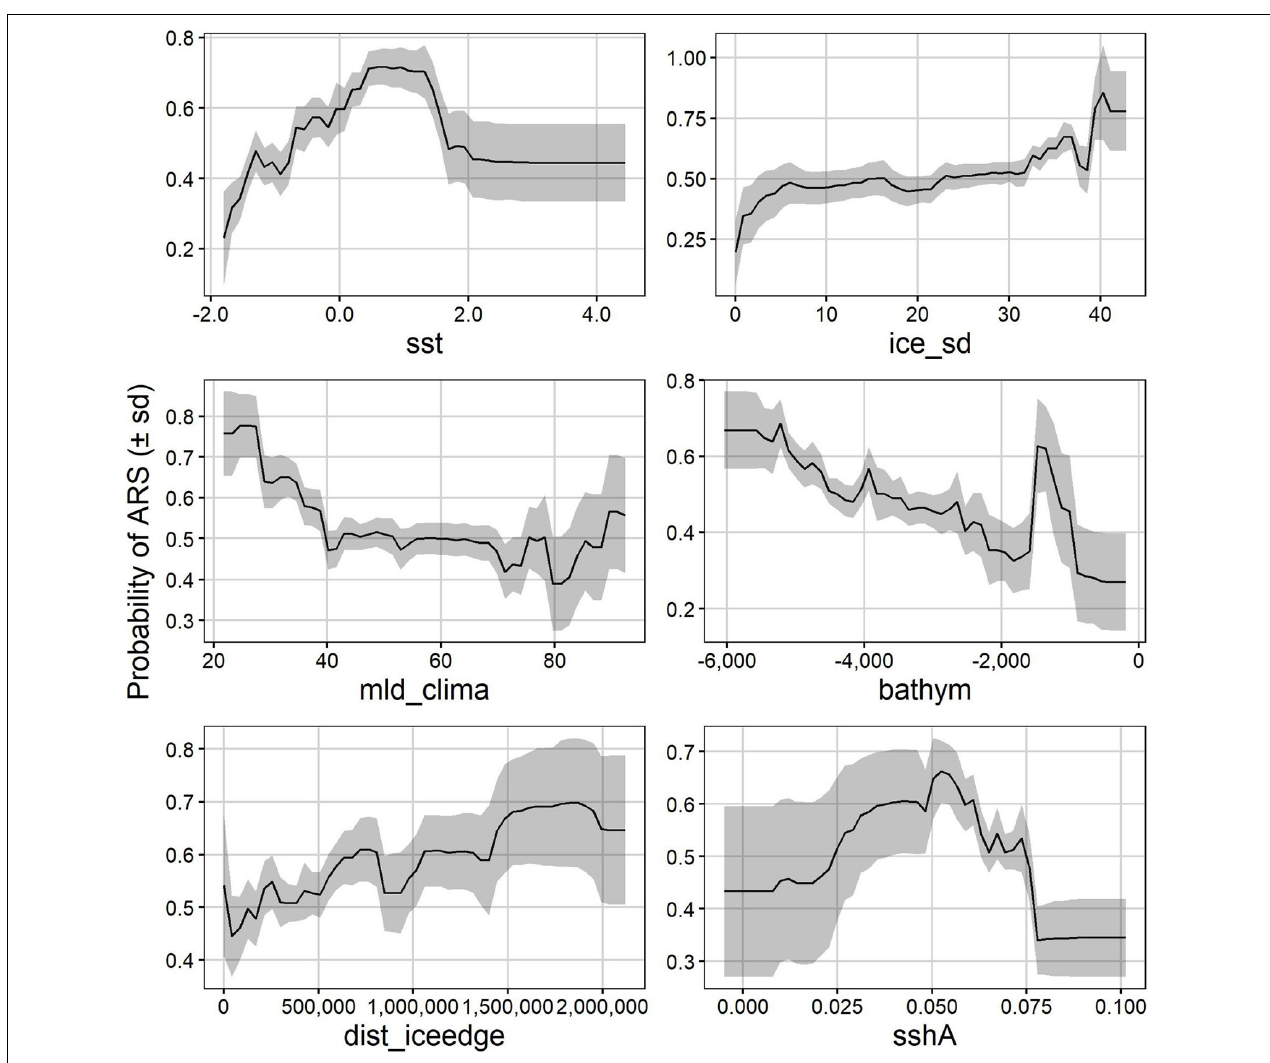
FIGURE 5 | Summer partial dependence plots showing how the probability of area restricted search (ARS) is influenced by the top six environmental variables. Mean probability of ARS (solid line) ± sd (grey shaded) across the 500 bootstraps are shown. Bathym, bathymetry (m); dist_iceedge, distance from the ice edge (m); ice_sd, ice concentration standard deviation; mld_clima, mixed layer depth climatology (m); sst, sea surface temperature ( ◦ C); sshA, sea surface height anomaly